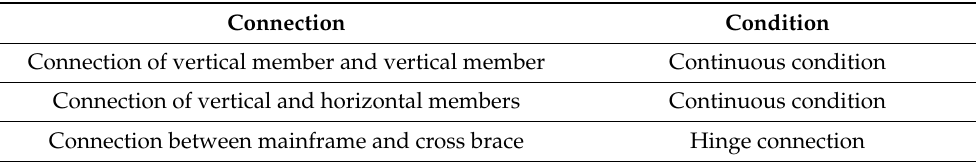
Table 9. Connection conditions for mobile scaffold members.